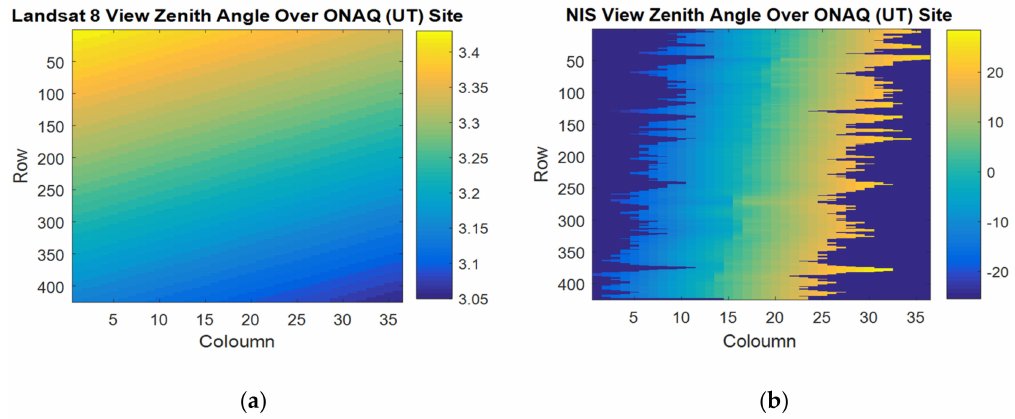
Figure 13. ( a ) Landsat 8 OLI view zenith angle over the Onaqui-Ault (ONAQ) Scene; ( b ) NIS view zenith angle over the ONAQ